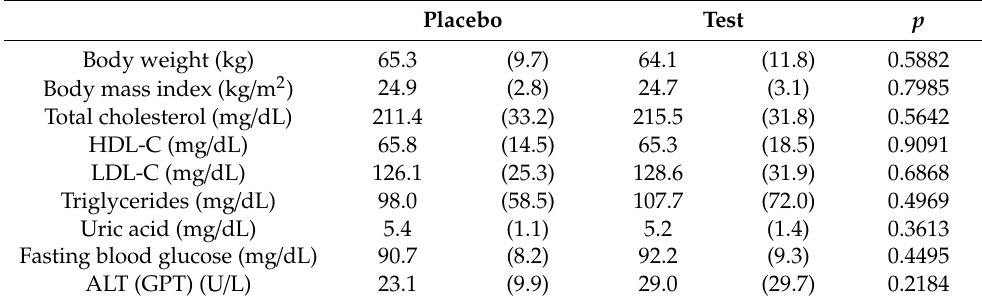
Table 5. Body weight, risk factors, and representative values of liver function at 12